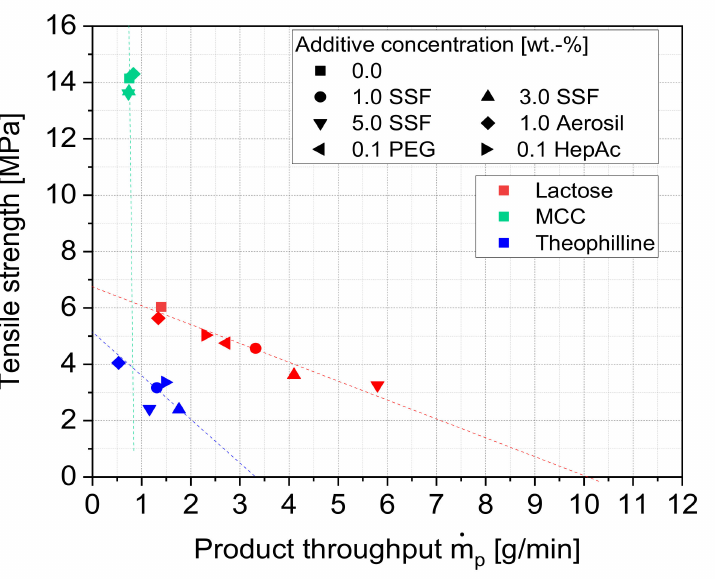
. m p , during the jet milling and the tensile